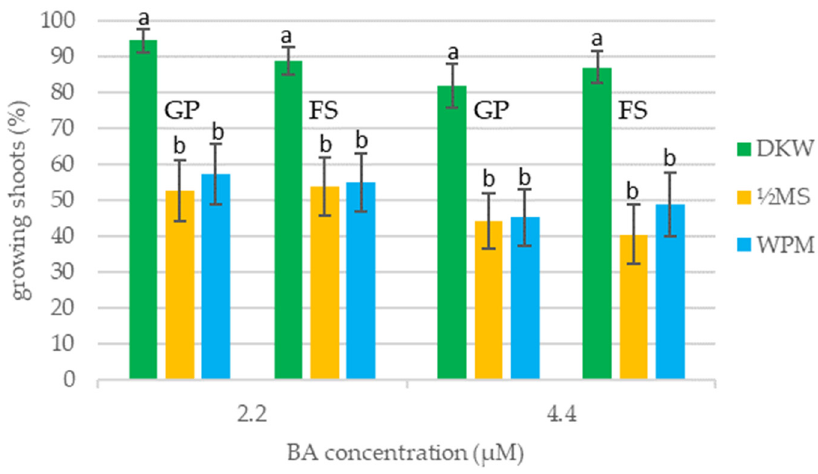
Figure 2. The percentage of shoot apices taken from greenhouse plants (GP) and field sprouts (FS) that grew in response to the treatments of three basal media DKW (green), 1 / 2 MS (orange), and WPM (blue) and two different concentrations of BA ( µ M). Total number of tested shoot apices from left to right: 54, 36, 35, 72, 39, 40, 39, 43, 42, 62, 37, 41. Error bars represent standard error. DKW medium resulted in significantly higher frequency of growing shoots than 1 / 2 MS and WPM media, as indicated by different letters above bars (two-way ANOVA and Fishers LSD, p < 0.05).